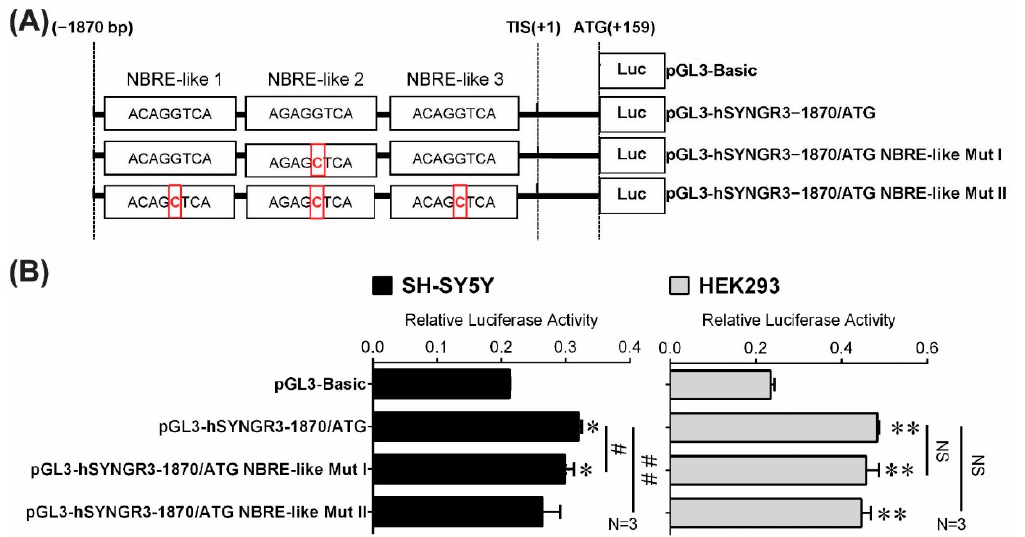
Figure 5. Effects of putative ncNBRE sites on the transcription of SYNGR3. ( A ) Site-directed mutagenesis of the three putative ncNBRE sites in pGL3-luciferase plasmids. ( B ) Comparison of the relative luciferase activities of wildtype and mutated putative ncNBRE sites in both neuronal SH-SY5Y and non-neuronal HEK293 cells. Data are expressed as mean ± SEM of three independent measurements. * p < 0.05 and ** p < 0.01 represent the statistical significance compared with pGL3-Basic plasmid. # p < 0.05 and ## p < 0.01 represent the statistical significance compared with native (pGL3-hSYNGR3 − 1870/ATG) construct. NS means no significance.